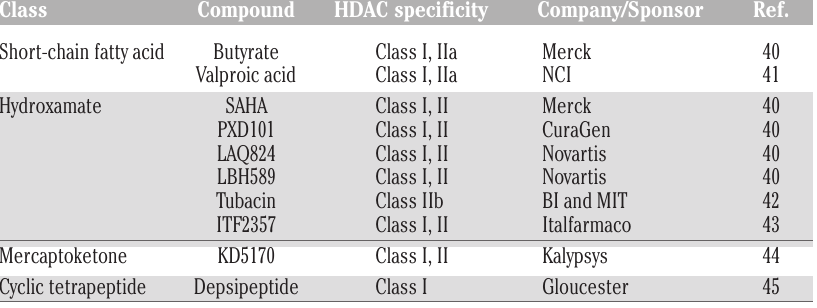
Table 1. Isoenzyme-selectivity of pan-HDACi.